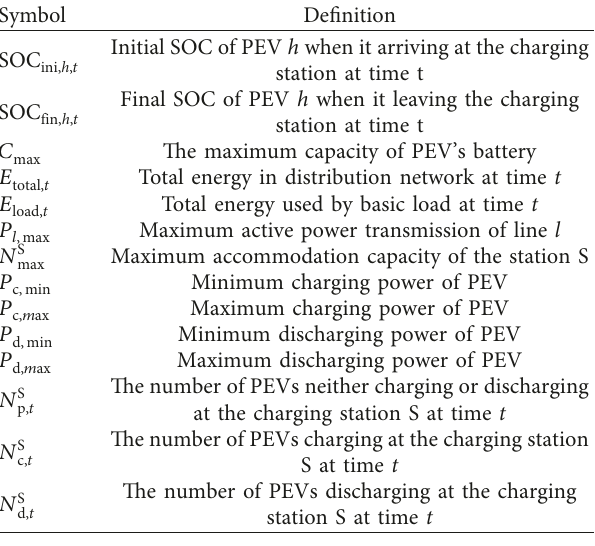
Figure 3: The flowchart of the number of PEVs charging and discharging. Table 1: The parameters of